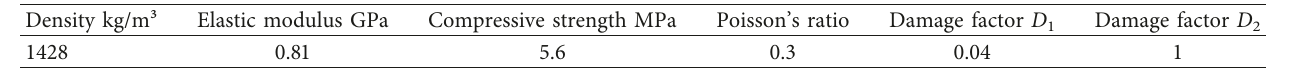
Table 2: Mechanical parameters used in the